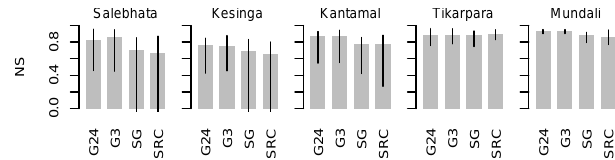
Figure 4. Nash–Sutcliffe indices of simulated runoff. Bars represent the values from Table 9 related to the entire evaluation period 2002– 2010. Thin vertical lines indicate the range of the Nash–Sutcliffe indices obtained for individual years ( y axis cut off at